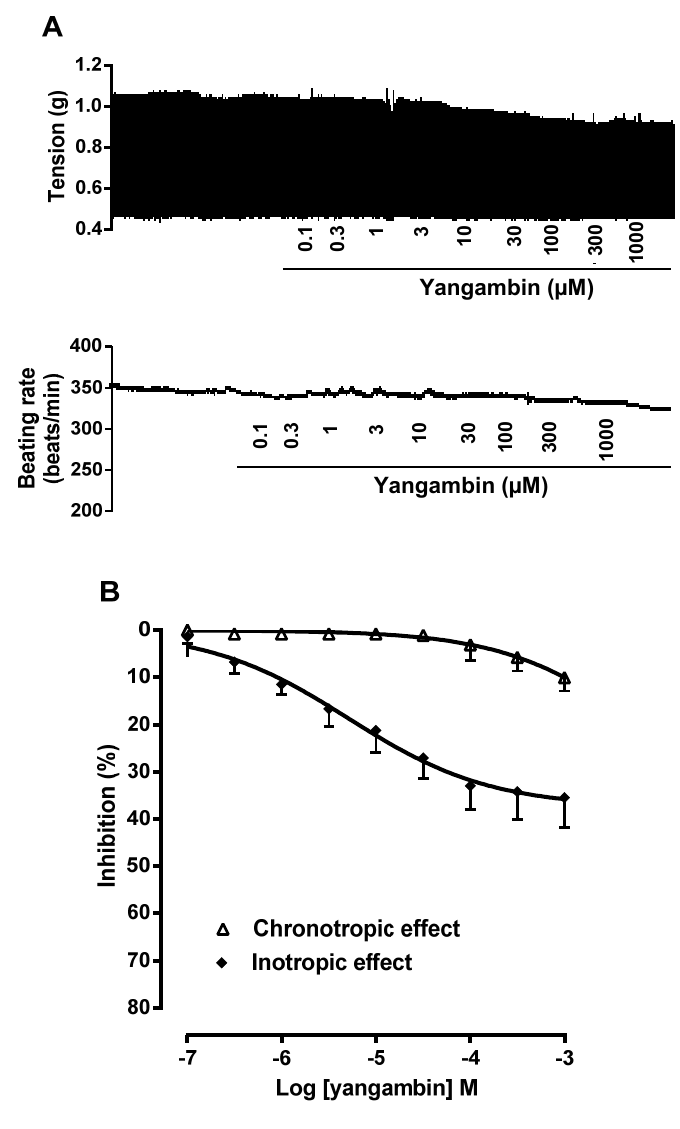
Figure 3. Effect of yangambin on isolated rat atria. (A) Representative tracings showing the effects of yangambin (0.1 µM–1 mM) on left atrial force contraction and right atrial beating rate. (B) Line plot graph showing the negative chronotropic and inotropic effects of yangambin (0.1 µM–1 mM) on isolated right and left rat atria, respectively. Values are mean ± S.E.M. ( n =